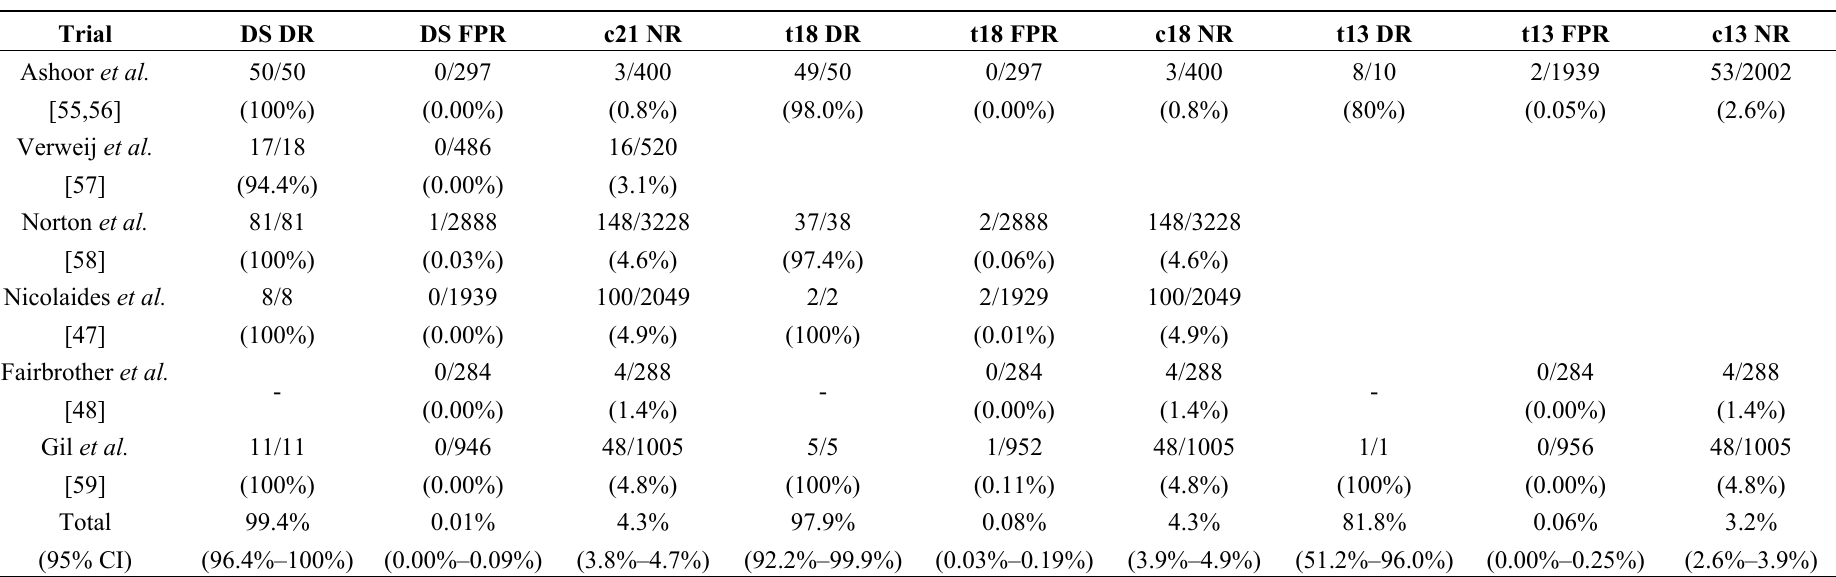
Table 2. Summary data for NIPT or non-mosaic autosomal aneuploidy using targeted massively parallel sequencing (t-MPS).